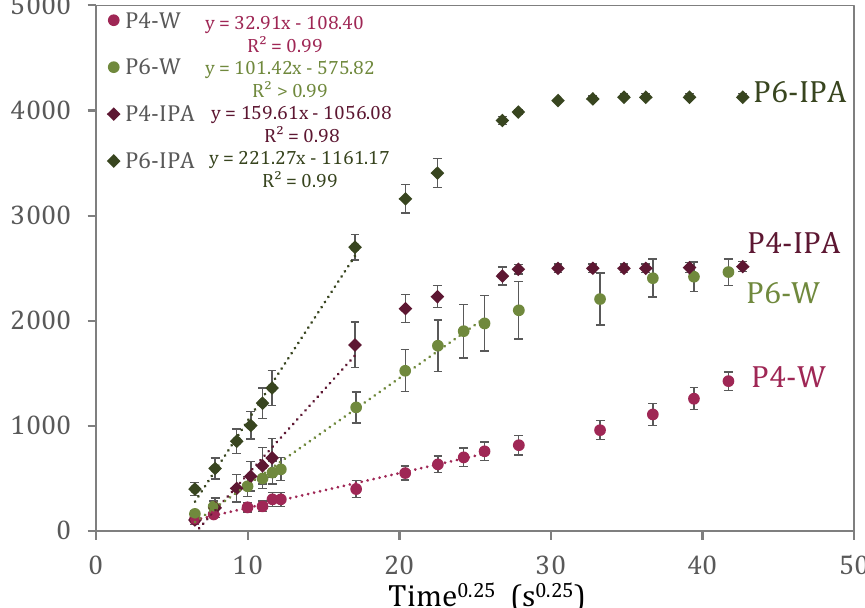
Figure 8. Long-term capillary imbibition performed with water (W) and isopropanol (IPA) in cement pastes P4 and P6. Dotted lines indicate the primary imbibition period (until the liquid reaches the top of the samples). The values of the slopes of the regression curves given above represent the CIR. Dark green and dark pink rhomboidal markers are results of P6 and P4 with IPA as imbibing liquid. Light green and light pink circle markers are results of P6 and P4 with W as imbibing liquid.